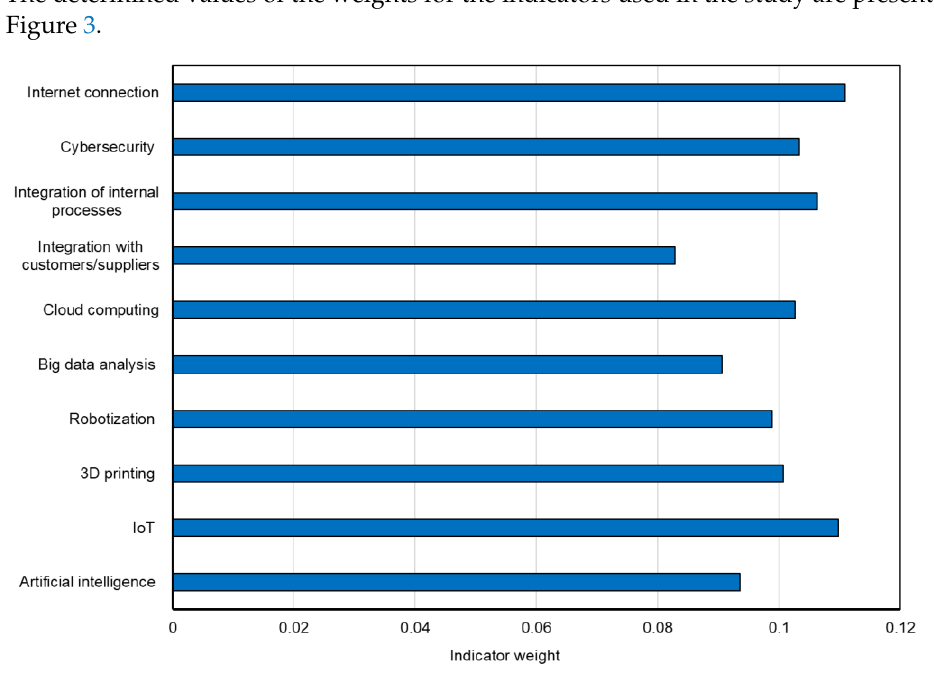
Figure 3. The values of weights for the indicators adopted for the study.